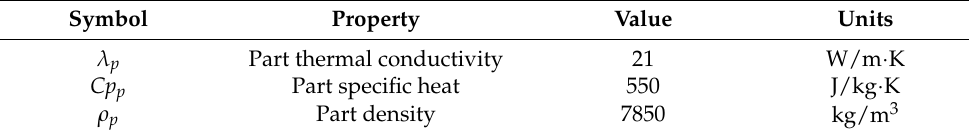
Table 1. Relevant physical properties of the 22MnB5 steel at room temperature.